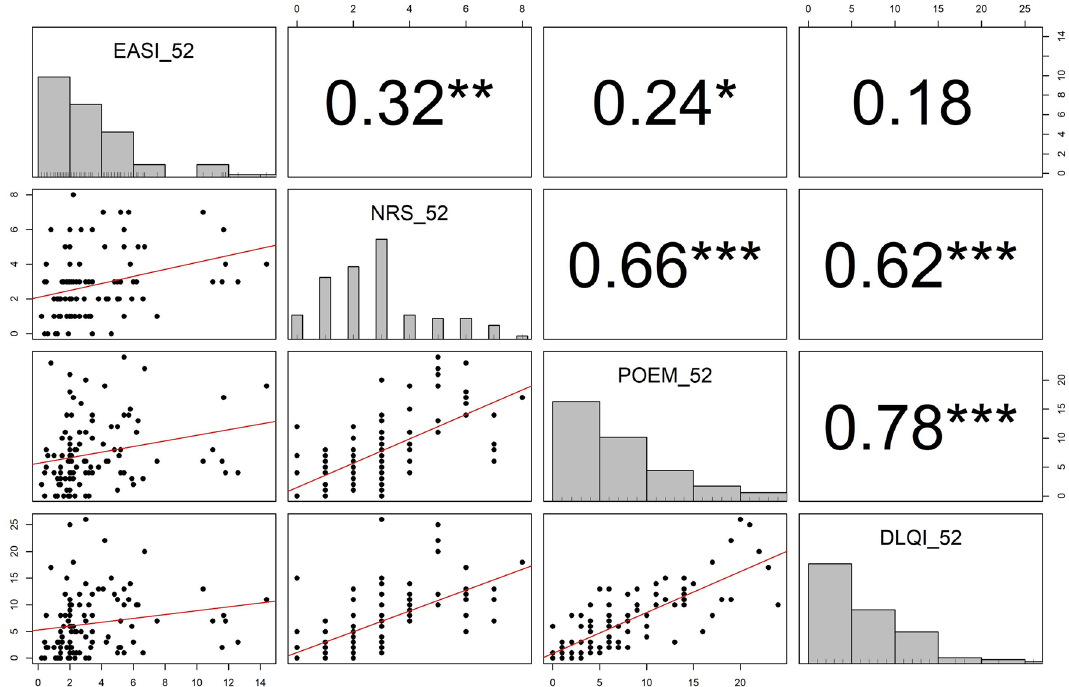
Figure 2. The correlation analysis between EASI, NRS, POEM, and DLQI at 52 weeks. All p-values less than 0.05, 0.01, or 0.001 are summarized as *, **, or ***, respectively.